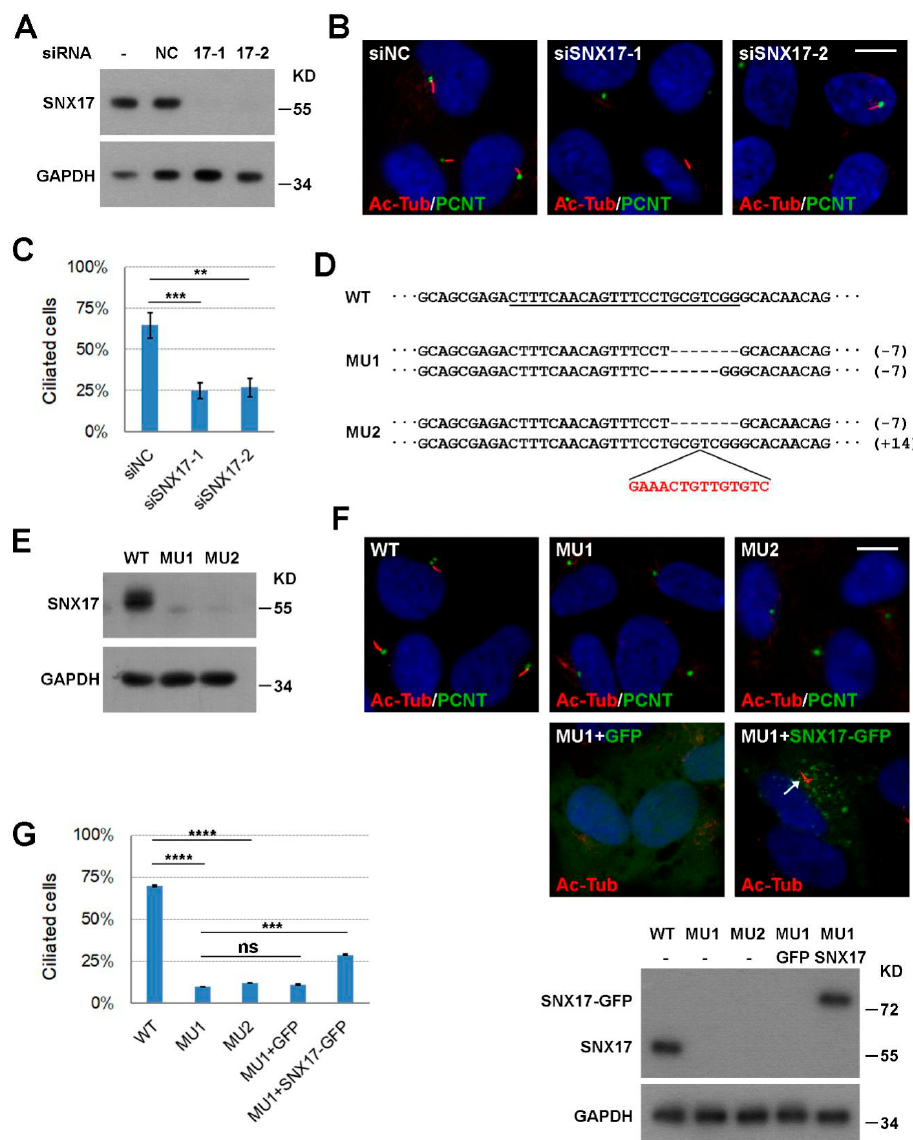
Figure 1. SNX17 is required for ciliogenesis. ( A ) Efficiency of siRNA-mediated knockdown of SNX17 in RPE1 cells as determined by western blot. NC is a negative control siRNA and 17-1 and 17-2 are two siRNAs to SNX17. GAPDH is loading control. ( B ) Representative immunofluorescence staining of cilia in siRNA-treated RPE1 cells at 48 h after serum starvation. Pericentrin (PCNT) is a centrosome marker and acetylated tubulin (Ac-Tub) labels cilia. ( C ) Statistical results of B. At least, one hundred cells were counted for ciliogenesis for each condition and three independent biological repeats were performed. Data represent mean ± SD from three independent biological repeats (** p < 0.01; *** p < 0.001 in one-way ANOVA with Dunnett’s multiple comparison). ( D ) CRISPR/Cas9 mediated knockout of SNX17 in RPE1 cells. The sgRNA targeting sequence in exon 2 of SNX17 gene is underlined. Two non-sense mutant cell lines with both alleles disrupted were recovered. ( E ) Western blot analysis for the expression of SNX17 in WT and mutant cell lines. ( F ) Cilium formation in WT and mutant cells at 48 h after serum starvation. Assays were performed as in B. The expression level of mouse SNX17-GFP is comparable to the endogenous SNX17 as determined by western blot using the SNX17 antibody (bottom panel). Lentivirus-mediated expression of SNX17-GFP but not GFP partially rescued cilia defect in MU1 cells (arrows). ( G ) Statistical results of ( F ). Data represent mean ± SD from three independent biological repeats (ns, non-significant; *** p < 0.001; **** p < 0.0001 in one-way ANOVA with Tukey’s multiple comparison test). Scale bar, 10 µ